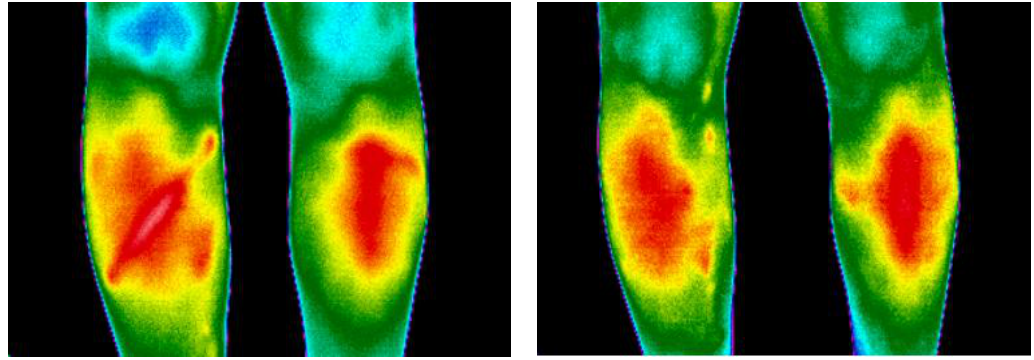
Figure 6. Infrared image of the anterior aspect of the knees (fracture tibia and fibulae in the right knee).